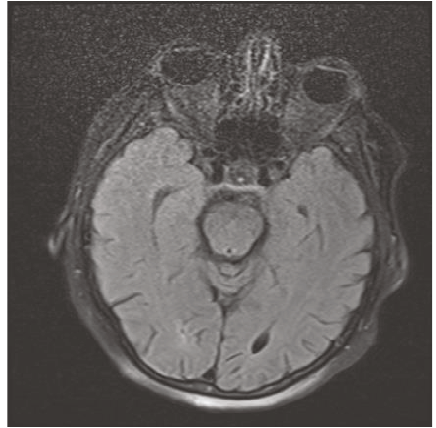
Figure 2: Axial T1-weighted sequence through the